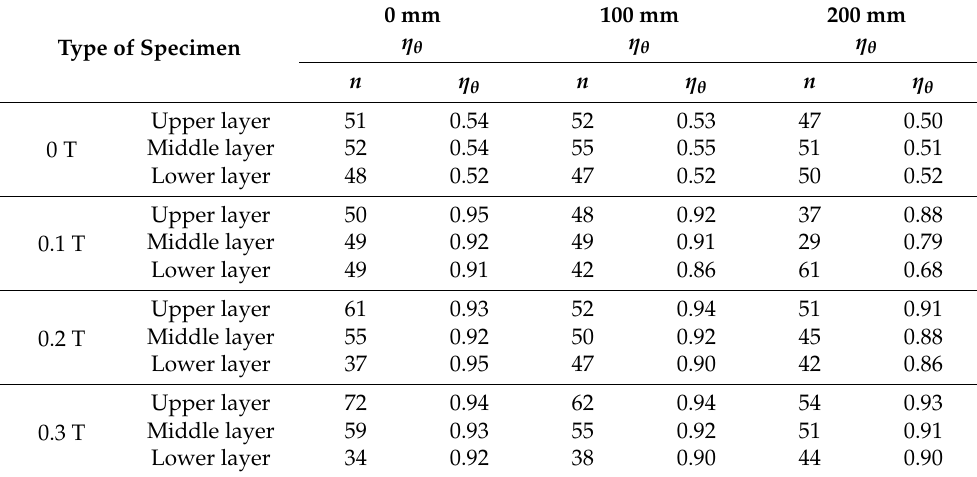
Table 3. The orientation effective coefficient ( η θ ) and the number of steel fibers ( n ) in each part of the cross-sections of the